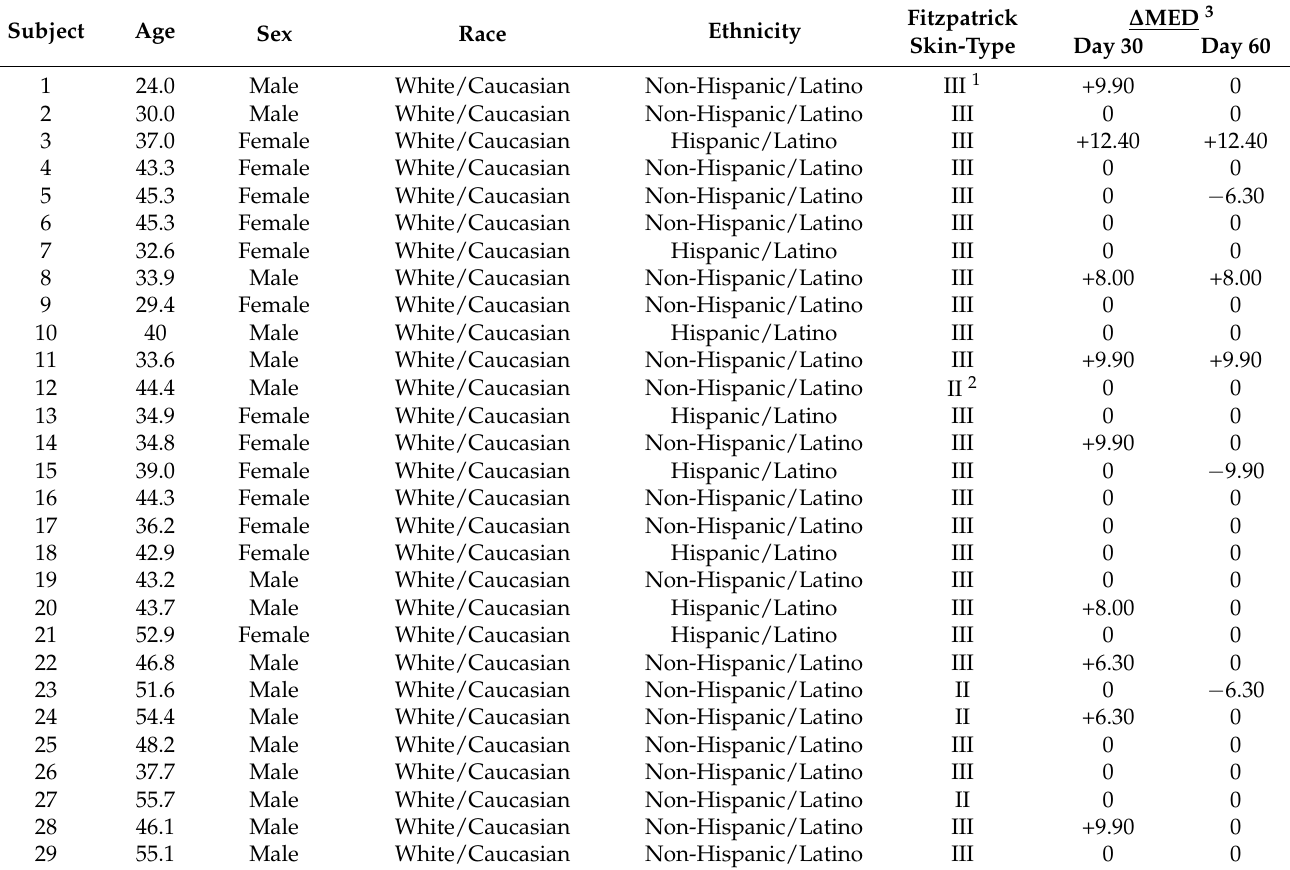
Table 1. Subject demographics, skin type, and change in minimal erythema dose (MED)